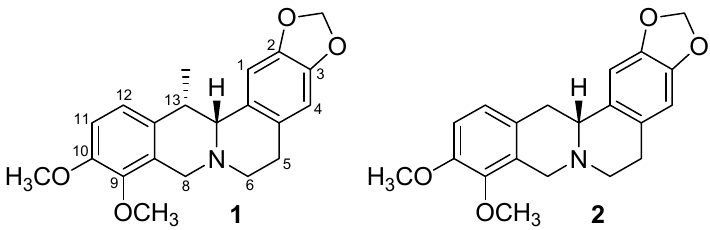
Figure 1. Structures of protoberberine alkaloids (+)-thalictricavine ( 1 ) and (+)-canadine ( 2 ).